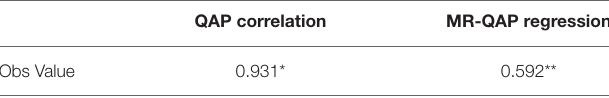
TABLE 2 | Correlation and regression analysis of two semantic